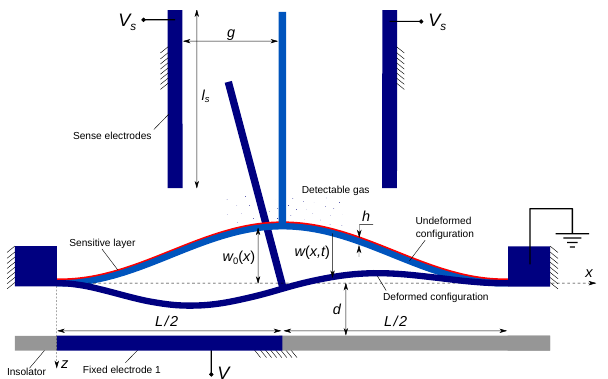
Figure 16. Schematic of the differential capacitance gas